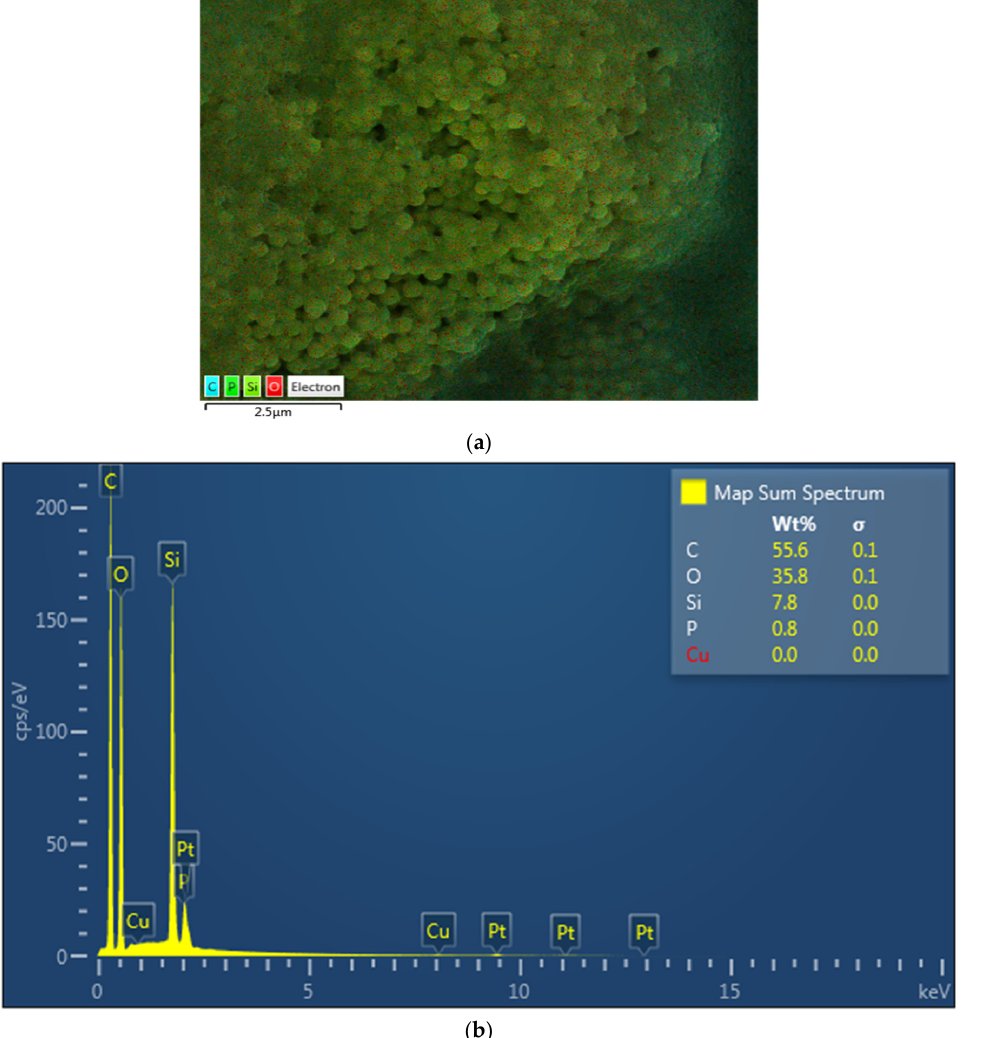
Figure 1. ( a ): Electron image of the resin cement, Multilink. ( b ): EDX for Multilink cement showing Si for glass silica, O for spheroid oxides, and C for carbon in the dimethacrylate and HEMA monomers.